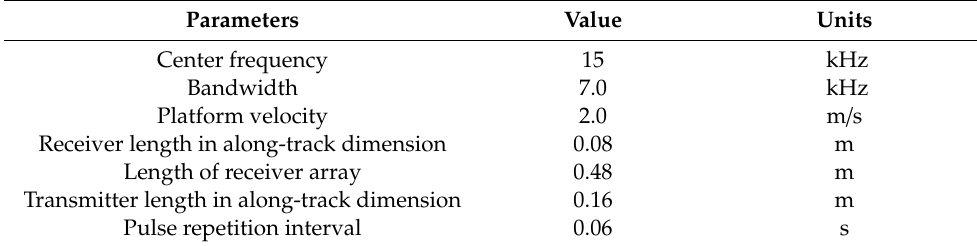
Table 1. The Parameters of the new sub-bottom profiler.